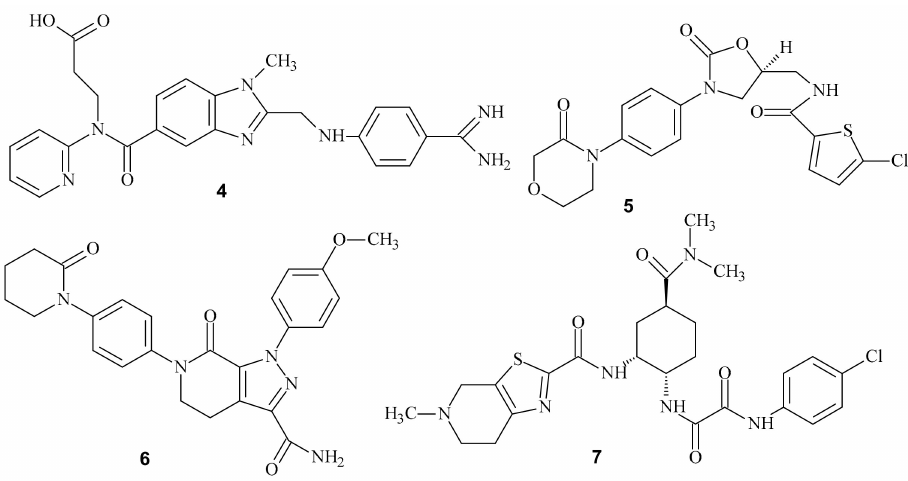
Figure 3. Structures of selected non-VKA oral anticoagulants